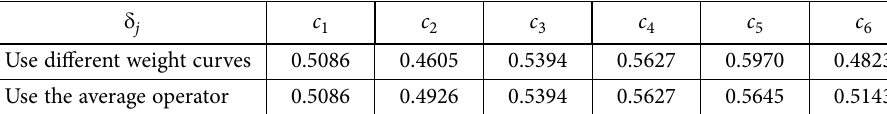
Table 14. Final performance scores under different aggregation of online